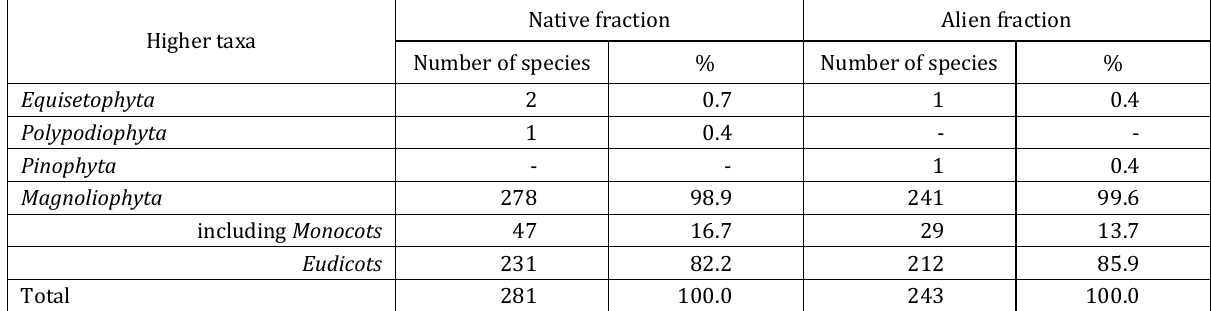
Table 1. Higher taxa of the spontaneous flora of the Botanic Garden Native